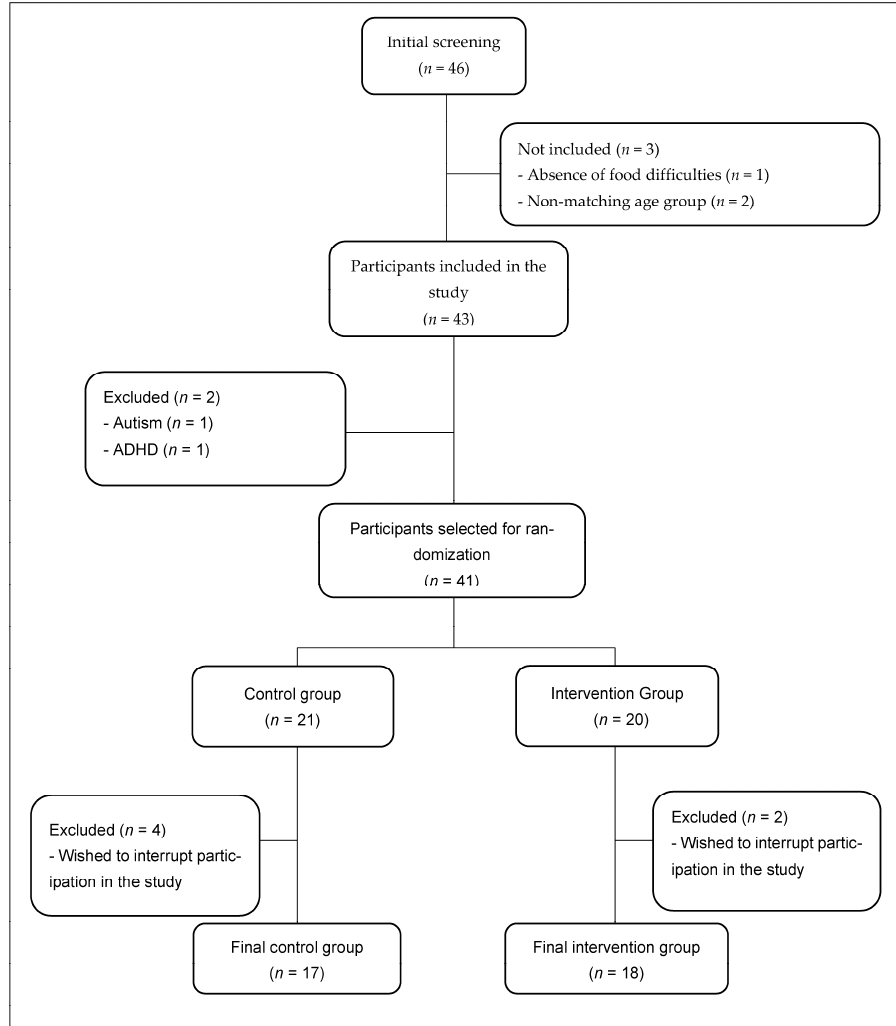
Figure 1. Participant selection flowchart.